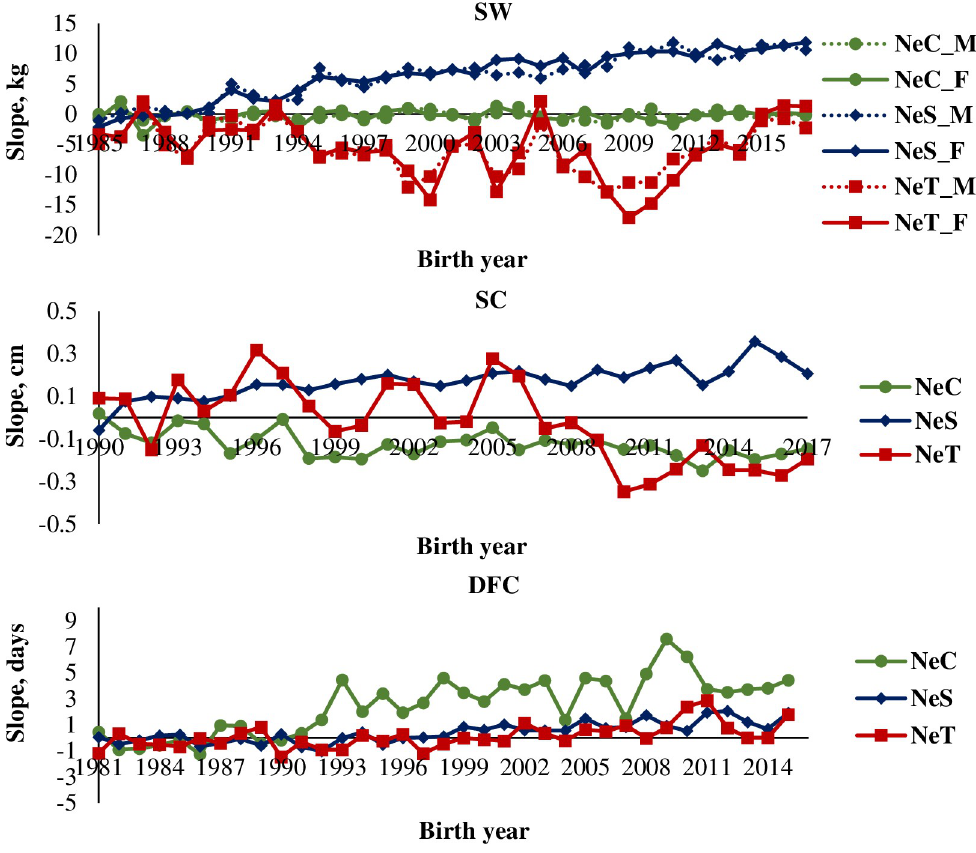
Fig 4. Genetic trends for regression coefficients related to the slope of reaction norms for Selection Weight (SW), Scrotal Circumference (SC), and Days at First Calving (DFC) in three Nellore cattle lines (NeC, control; NeS, selection; and NeT, traditional). NeC_M, males of the control line; NeC_F, females of the control line; NeS_M, males of the selection line; NeS_F, females of the selection line; NeT_M, males of the traditional line; NeT_F, females of the traditional